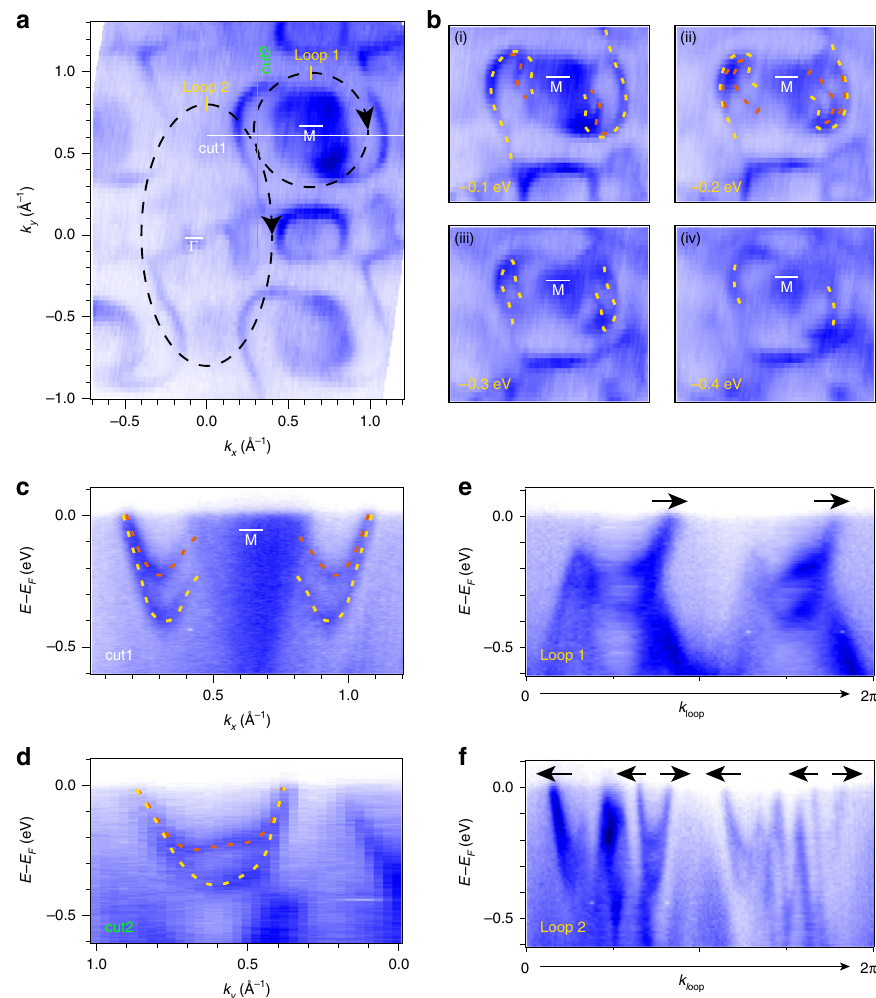
Fig. 4 SOC-induced spin-split Fermi arcs. a FS intensity plots obtained with photon energy, h ν = 60 eV. b Series of constant energy maps with different binding energies, (i) – (iv) Δ E = E − E F = − 0.1, − 0.2, − 0.3, and − 0.4 eV, respectively. The yellow and orange dashed lines are guide-to-eye of the Fermi arcs. c , d ARPES spectra, obtained with photon energy, h ν = 60 eV, along the k x and k y directions across the Fermi arcs, indicated by the white and green lines respectively in a . e , f ARPES spectra along loop 1 and loop 2, respectively. The paths of the loops are shown in a , starting from the yellow marks and proceeding clockwise. The black arrows are indications of Fermi-arcs ’ Fermi